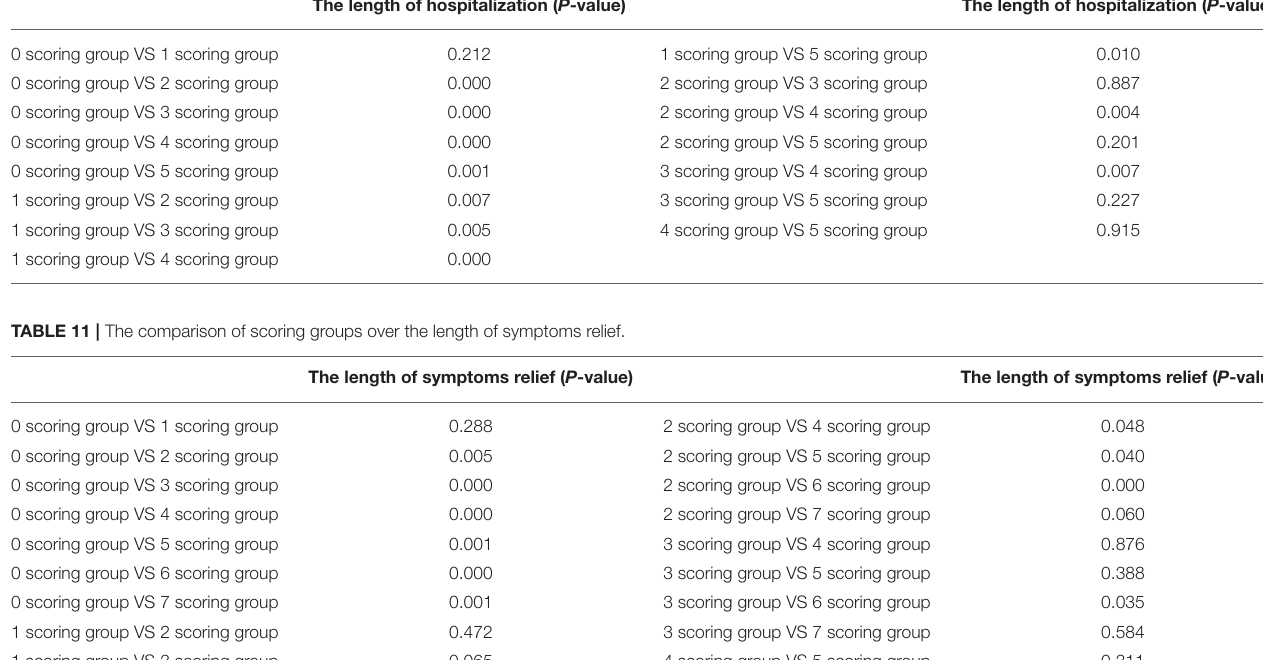
TABLE 10 | The comparison of scoring groups over the length of hospitalization. The length of hospitalization ( P -value) The length of hospitalization ( P -value)